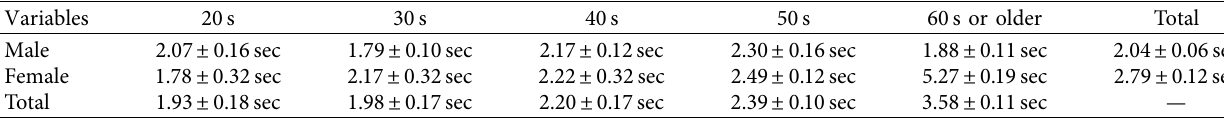
Table 17: Takeover time by gender and age.